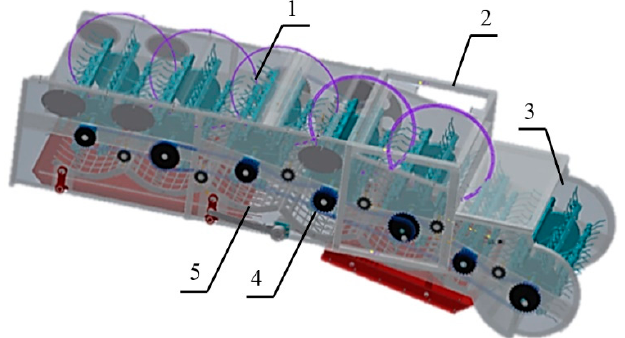
Figure 2. Overall structure of the harvesting device. 1: Multi-stage tangential-flow harvesting